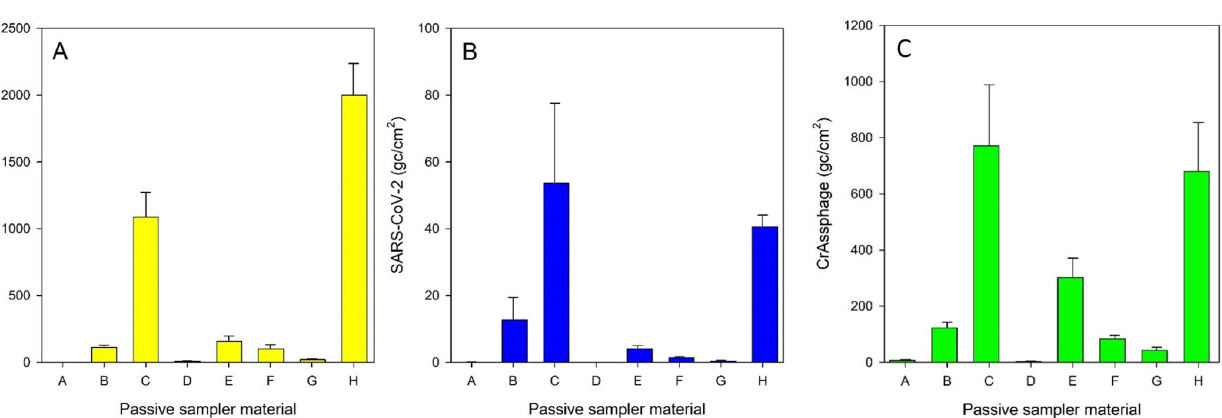
Figure 1. Recovery of the ( A ) enveloped virus Phi6, ( B ) SARS ‐ CoV ‐ 2 RNA, and ( C ) the faecal marker crAssphage from spiked wastewater by 8 different passive sampler materials after incubation for 1 h. Values represent means ± standard error (SEM) ( n = 3). The alphabetical key to the different passive sampler materials is presented in Table 1. gc: genome copies.